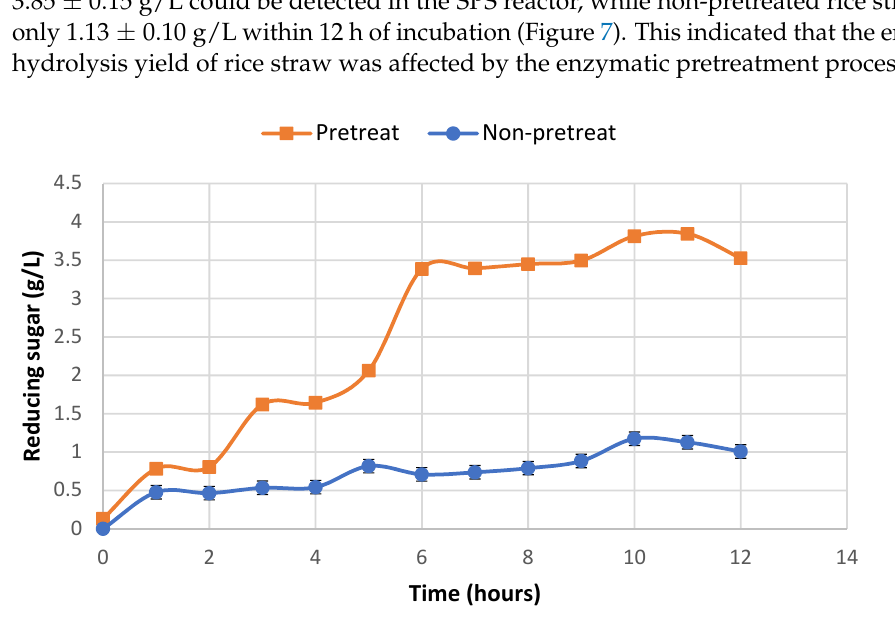
Figure 7. Time course of reducing sugar concentration during hydrolysis with simultaneous biolog- ical pretreatment and saccharification of rice straw and untreated rice straw.